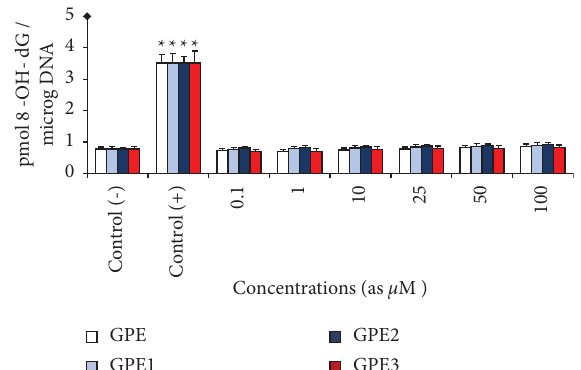
Figure 6: Te levels of 8-oxo-2-deoxyguanosine (8-OH-dG) adduct levels in human blood cultures treated with GPEs for 72h p < 0 . 05 ∗ .